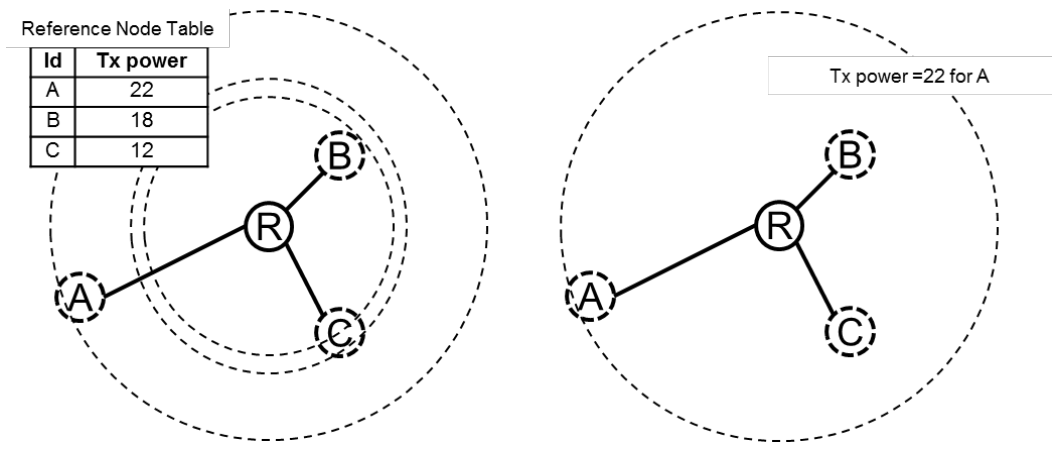
Figure 4. Link-level and network-level transmission power